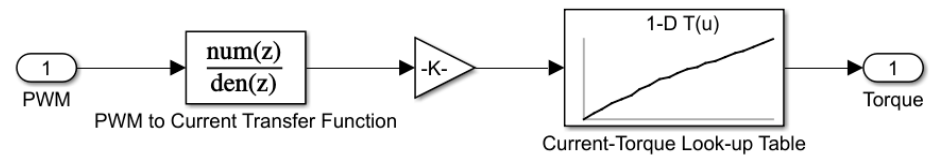
Figure 11. Electromagnetic powder brake model in Simulink.